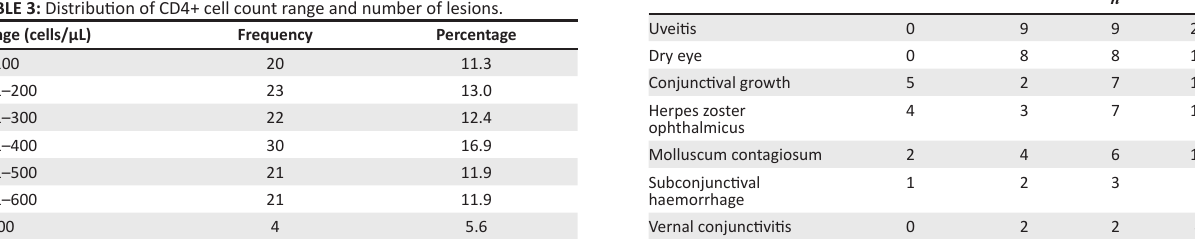
TABLE 2 : Distribution of visual acuity measurements of participants. Visual acuity